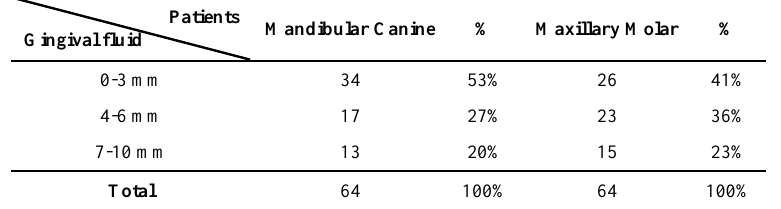
Table 8. Amount of gingival fluid shown in aggravation levels of clinical situation, patients second